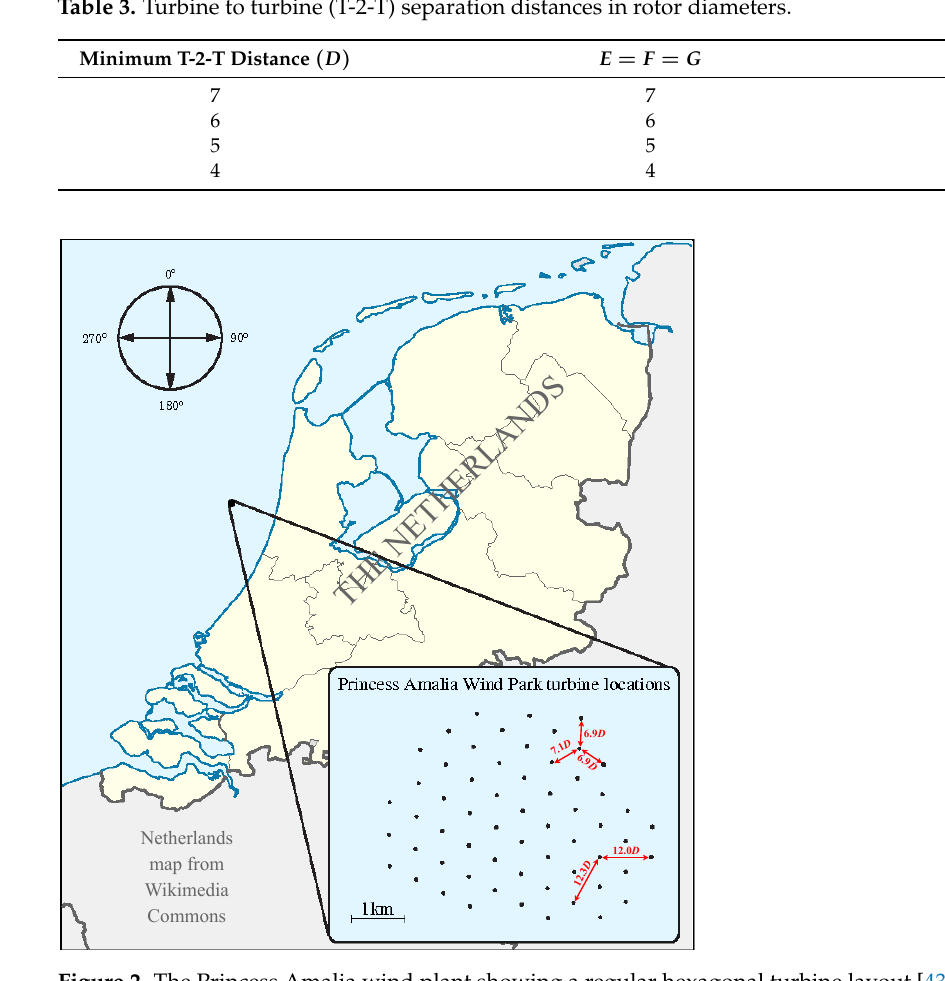
Figure 2. The Princess Amalia wind plant showing a regular hexagonal turbine layout [43].